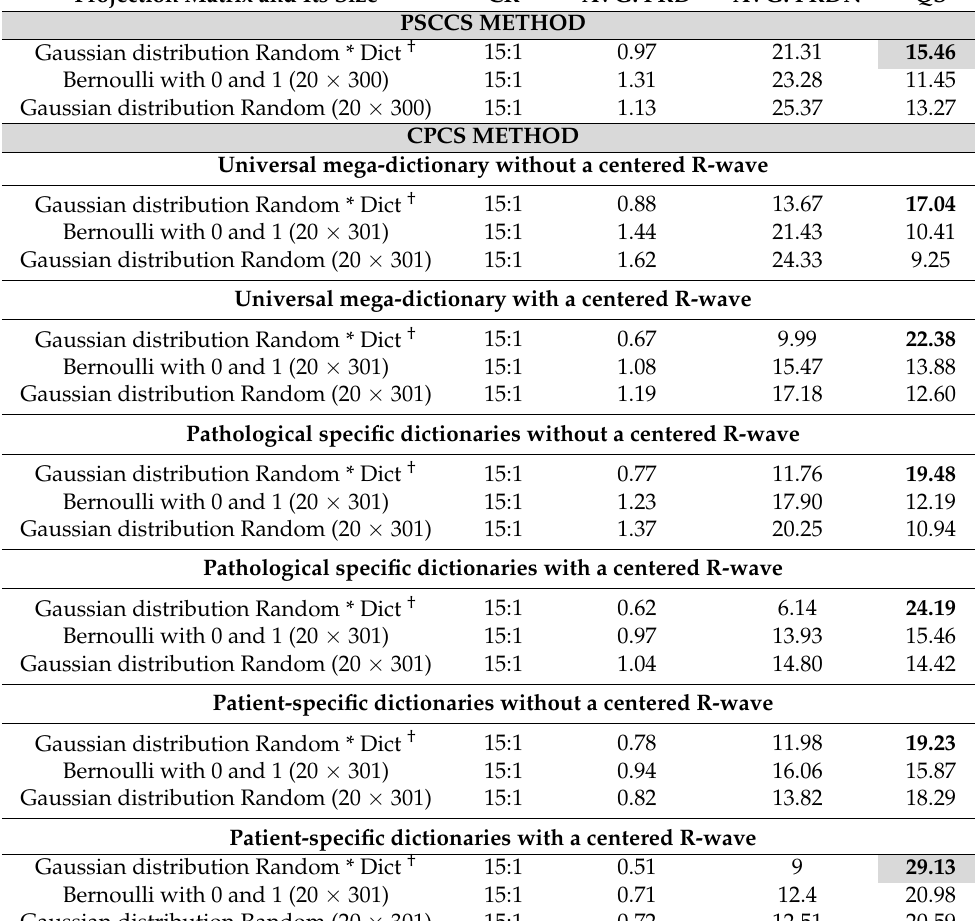
Table 9. Results summary for CR =